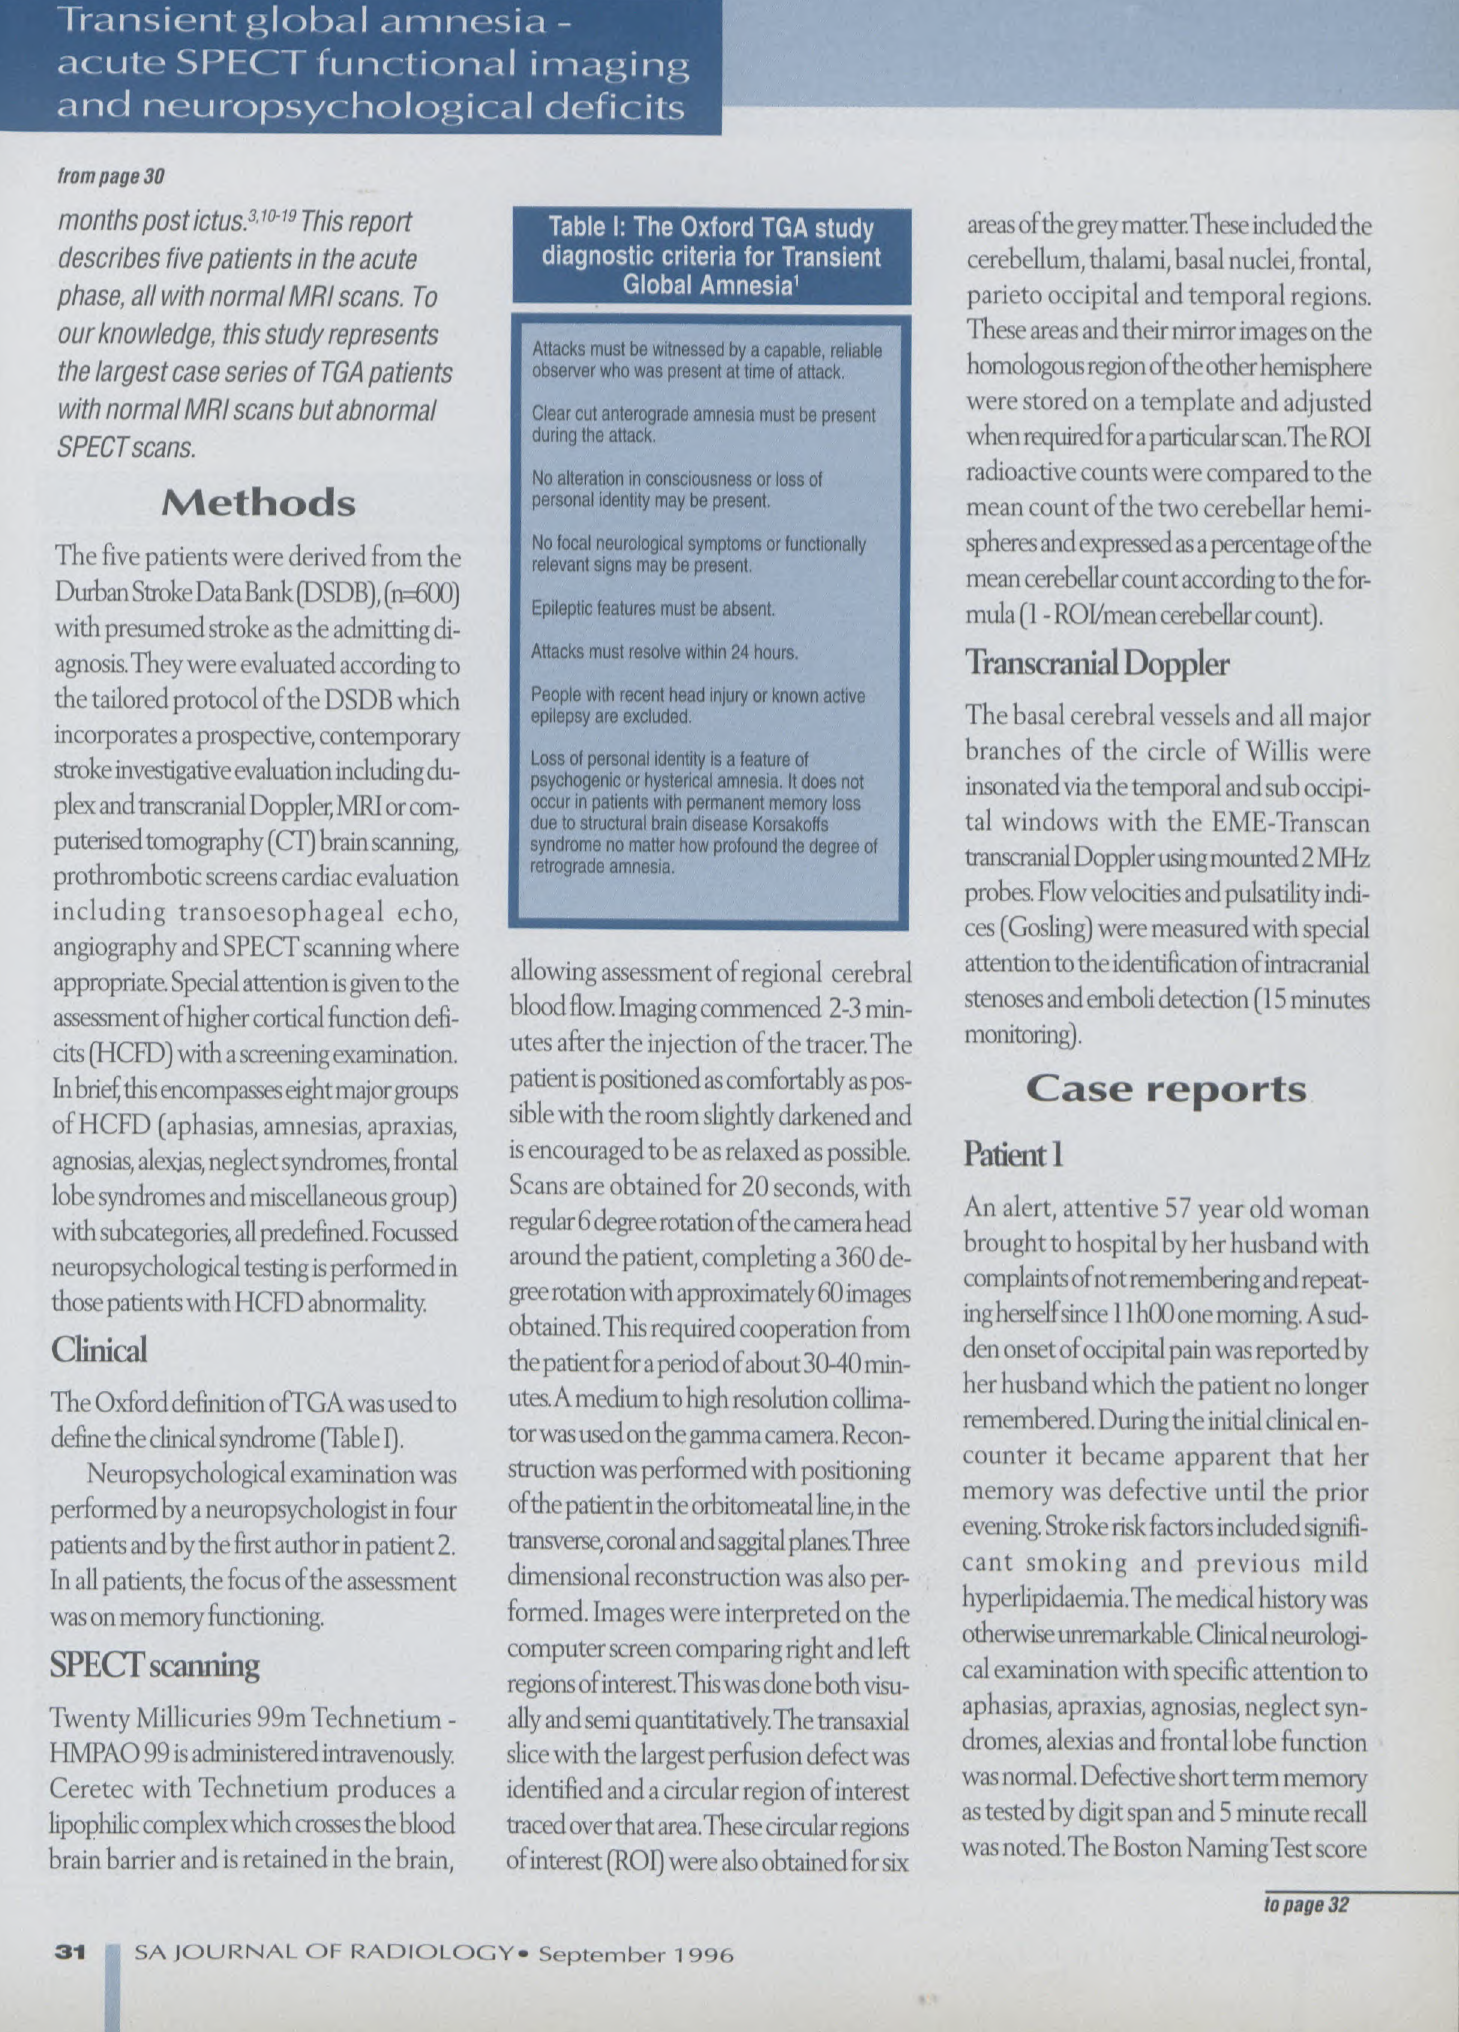
Table I: The Oxford TGA